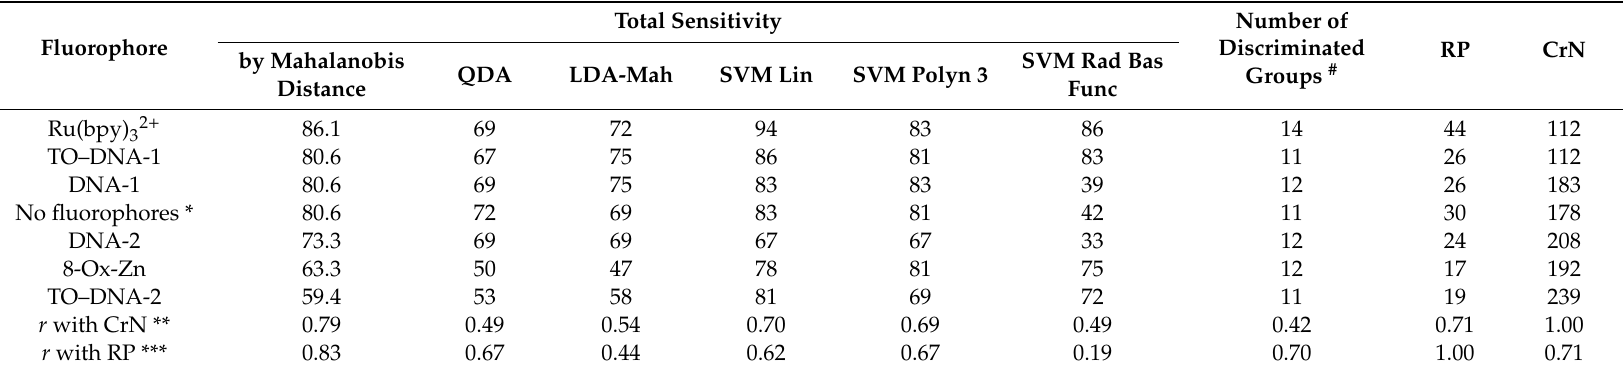
Discriminated RP CrN Groups #